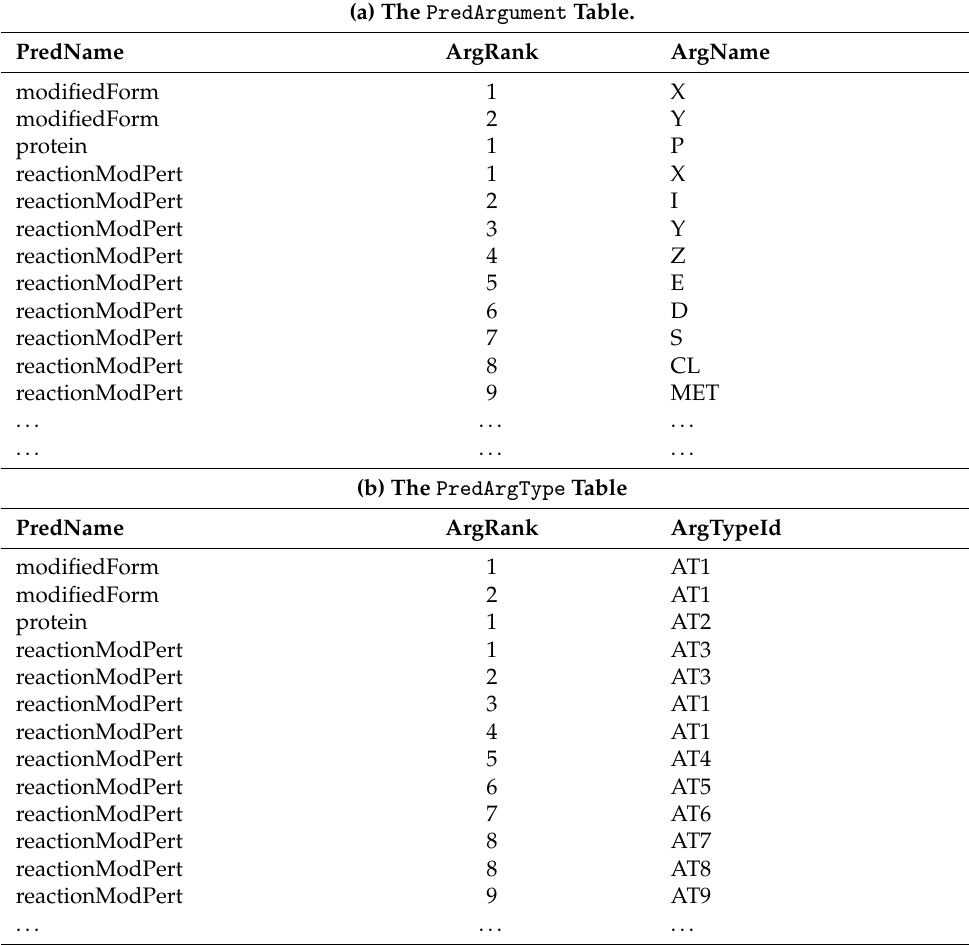
Table 7. Tables related to predicate arguments. (a) The PredArgument Table.